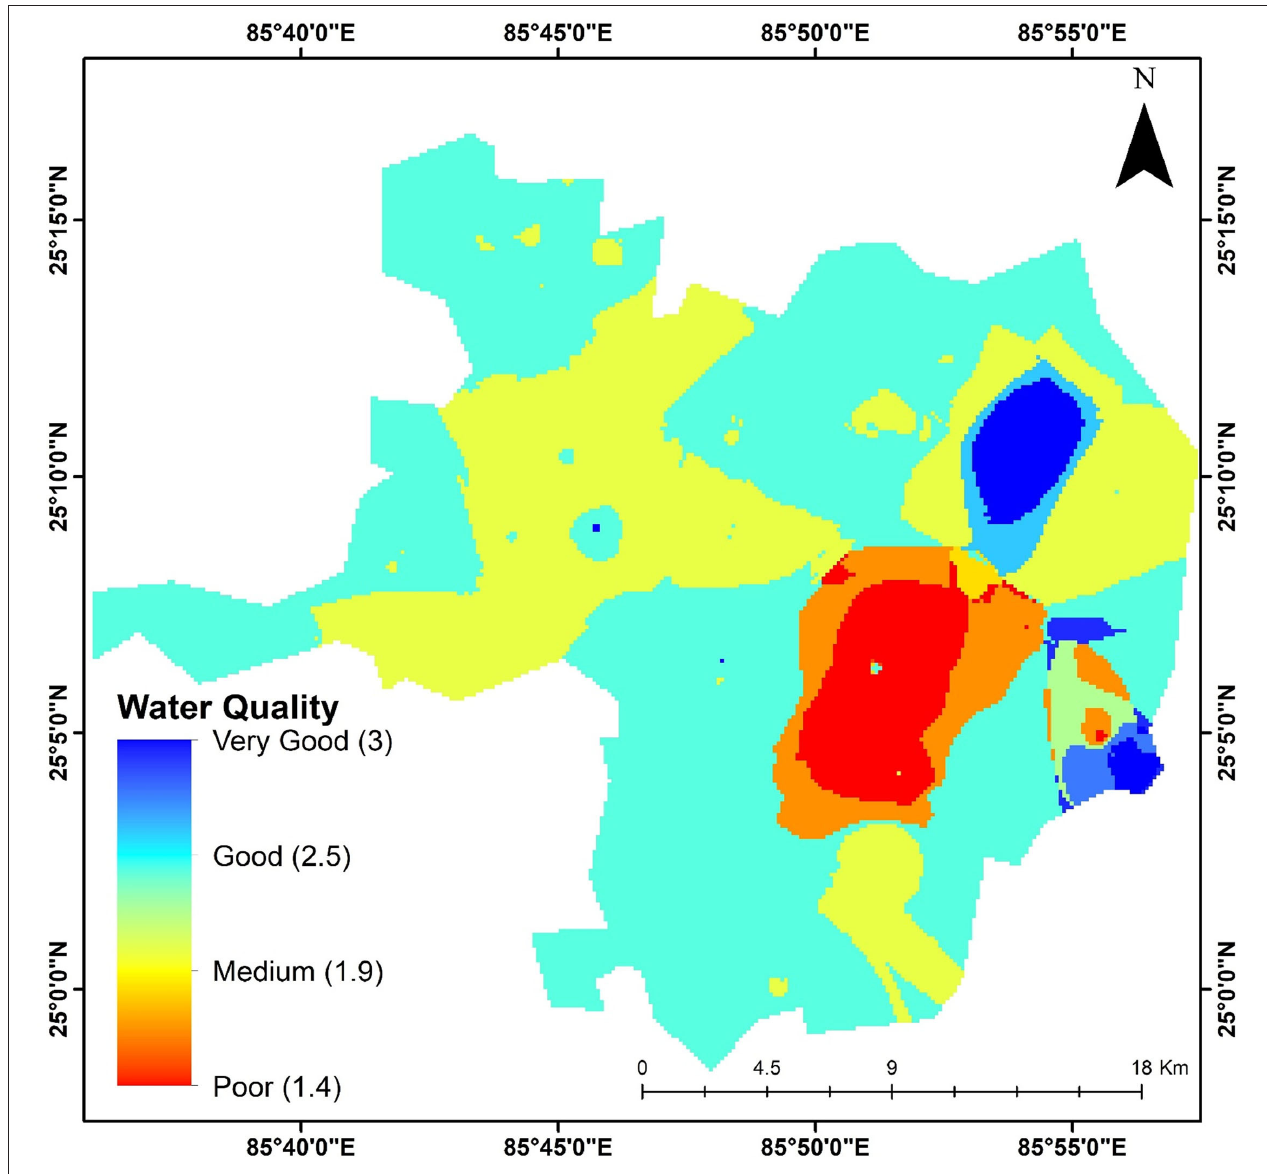
FIGURE 5 | Potential groundwater quality map for planning and management of groundwater harvesting and